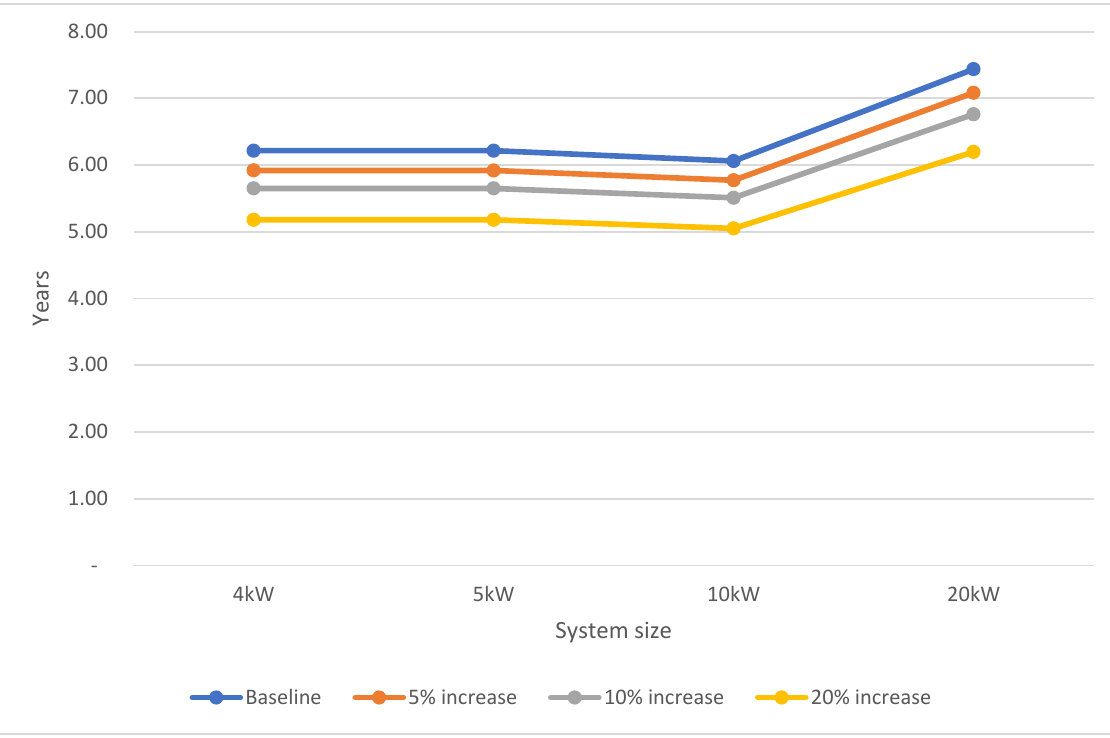
Figure 6. Changes to payback period to the changes in electricity tariffs.